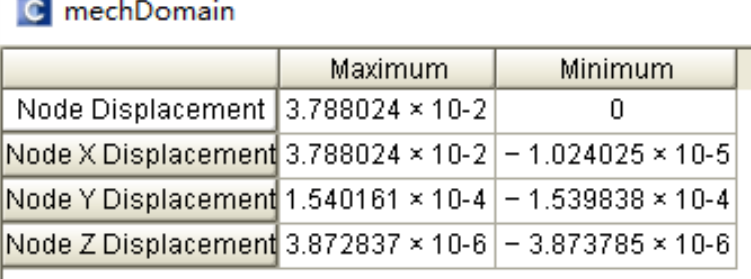
Figure 7. Displacement (um) of single-stage beam.